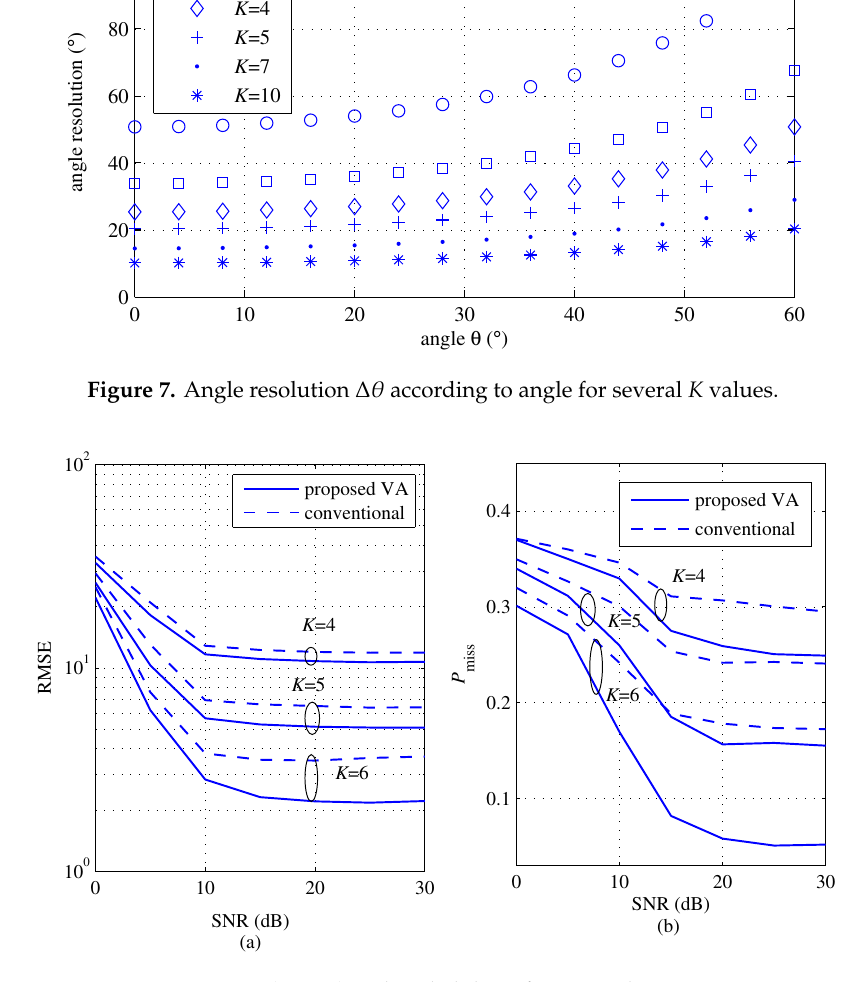
Figure 8. Root mean square error (RMSE) and probability of missing detection comparisons between the proposed and the conventional algorithms according to SNR for several K s with M = 2 ( θ 1 = − 10 ◦ , θ = 2 K − 1, ( a ) RMSE; ( b ) probability of missing = 11 ◦ ) and K 2 Ex